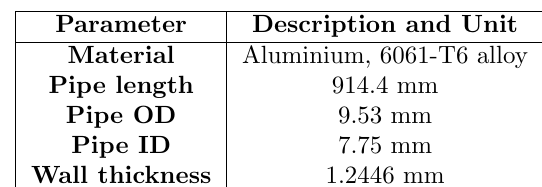
Figure 1: Drill rig.